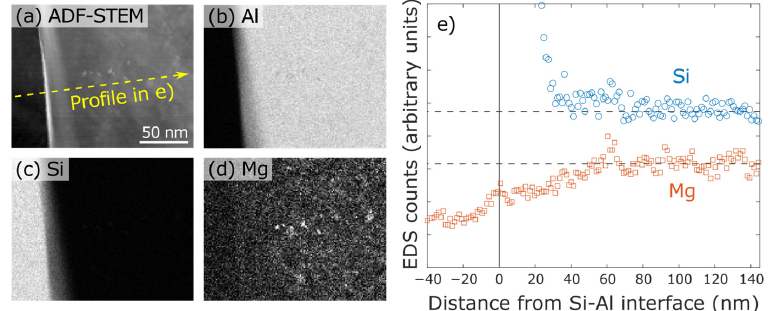
Figure 8. Solute concentration close to a Si particle in alloy Mg0.45Cu0.5, showing a narrow solute- depleted zone. depleted zone ( a – e